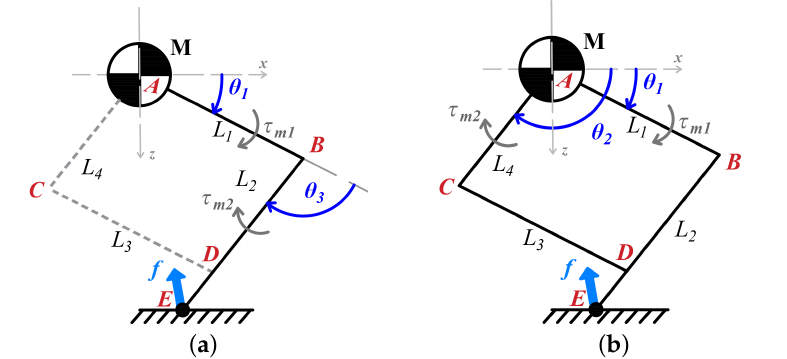
Figure 3. Comparison of serial and parallel legged structure: ( a ) serial structure; and ( b ) parallel structure.